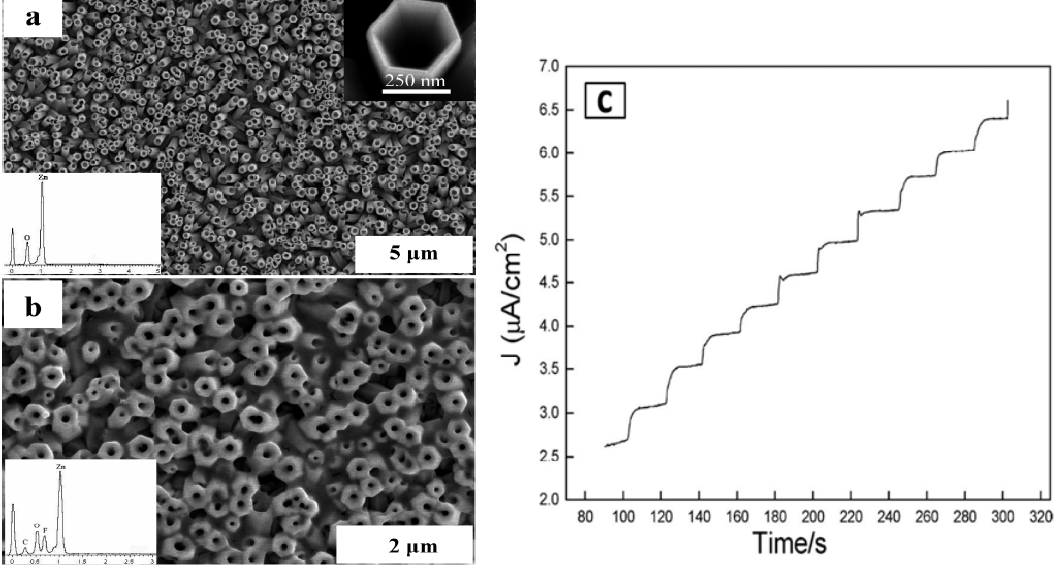
Figure 4. (a) Scanning electron microscope (SEM) image of the ZnO nanotube arrays; the energy dispersive X-ray spectroscopy (EDS) analysis (inset). (b) SEM image of the